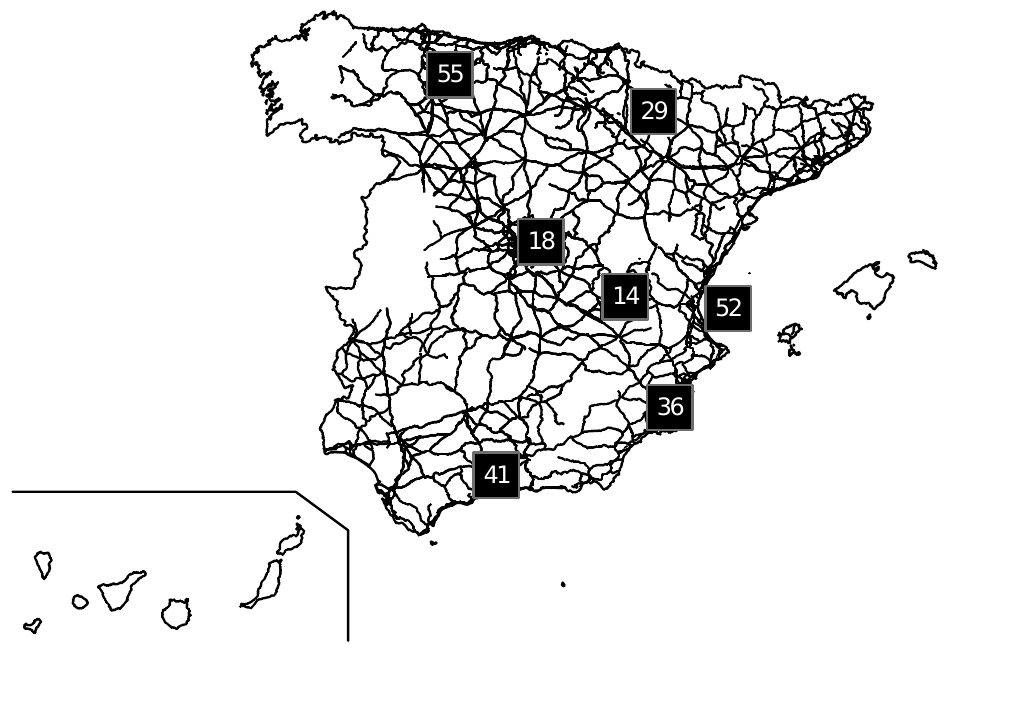
Figure 3: Locations of the 7-unit solution